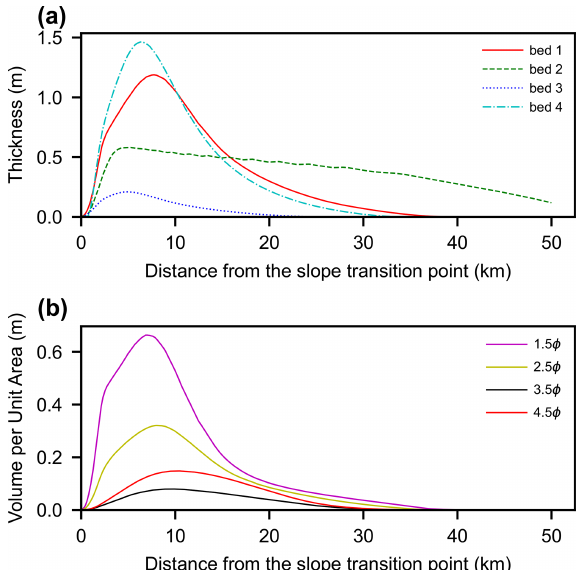
Figure 5. Results of training of the NN with different numbers of training datasets and lengths of the sampling